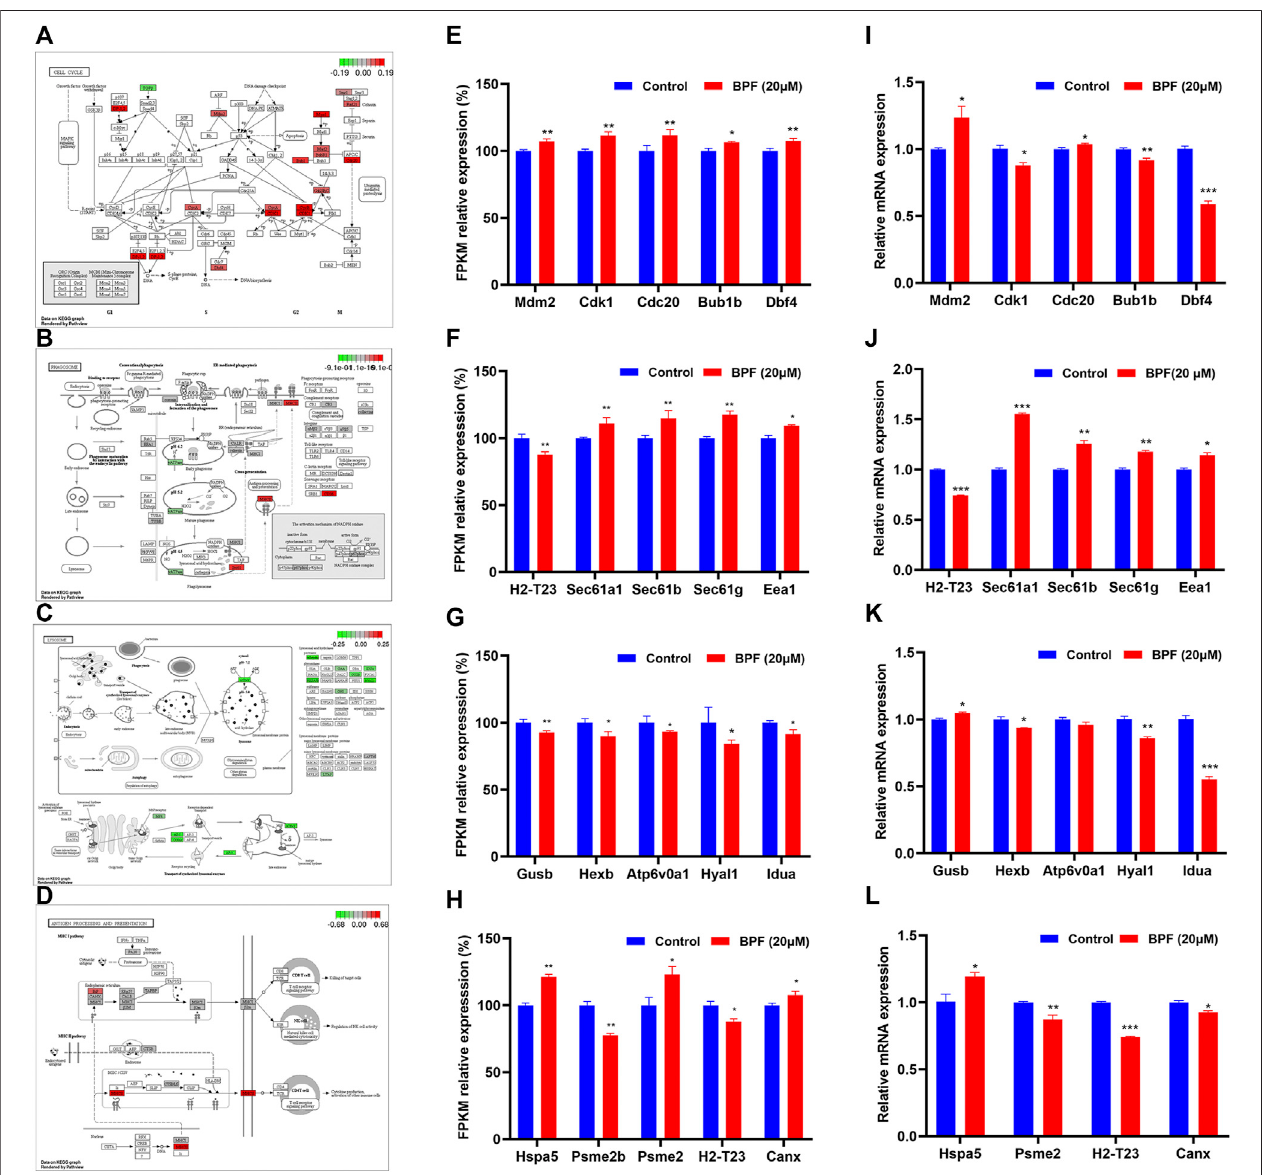
FIGURE5| Results oftheeffectsofBPFonthecellcycle,phagosome,lysosome,and antigenprocessingandpresentationpathway. (A – D) Schematicdiagramof the KEGG signaling pathway of cell cycle, phagosome, lysosome, and antigen processing and presentation pathway induced by BPF, respectively. Red and green symbols represent upregulated and downregulated gene expressions. (E – H) FPKM/relative expression levels of the top fi ve genes with signi fi cant difference in the aforementioned KEGG signaling pathway. (I – L) The mRNA levels of the top fi ve genes in the aforementioned KEGG signaling pathway re-con fi rmed by qRT-PCR. Data are expressed as means ± SEM. * p < 0.05, ** p < 0.01, and *** p < 0.001 are compared with the control group (0 μ M).